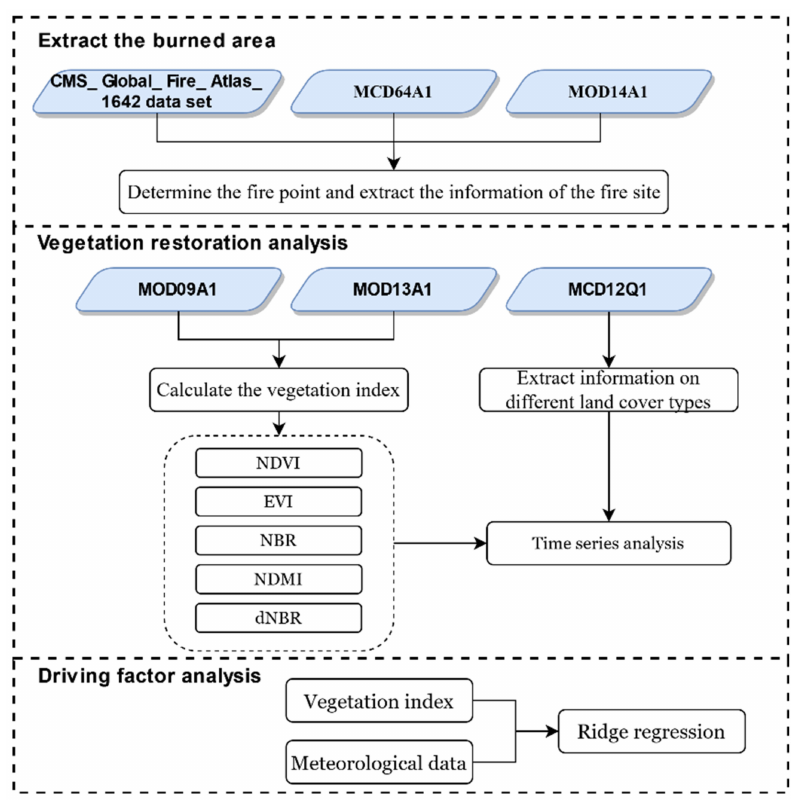
Figure 2. Research Process.